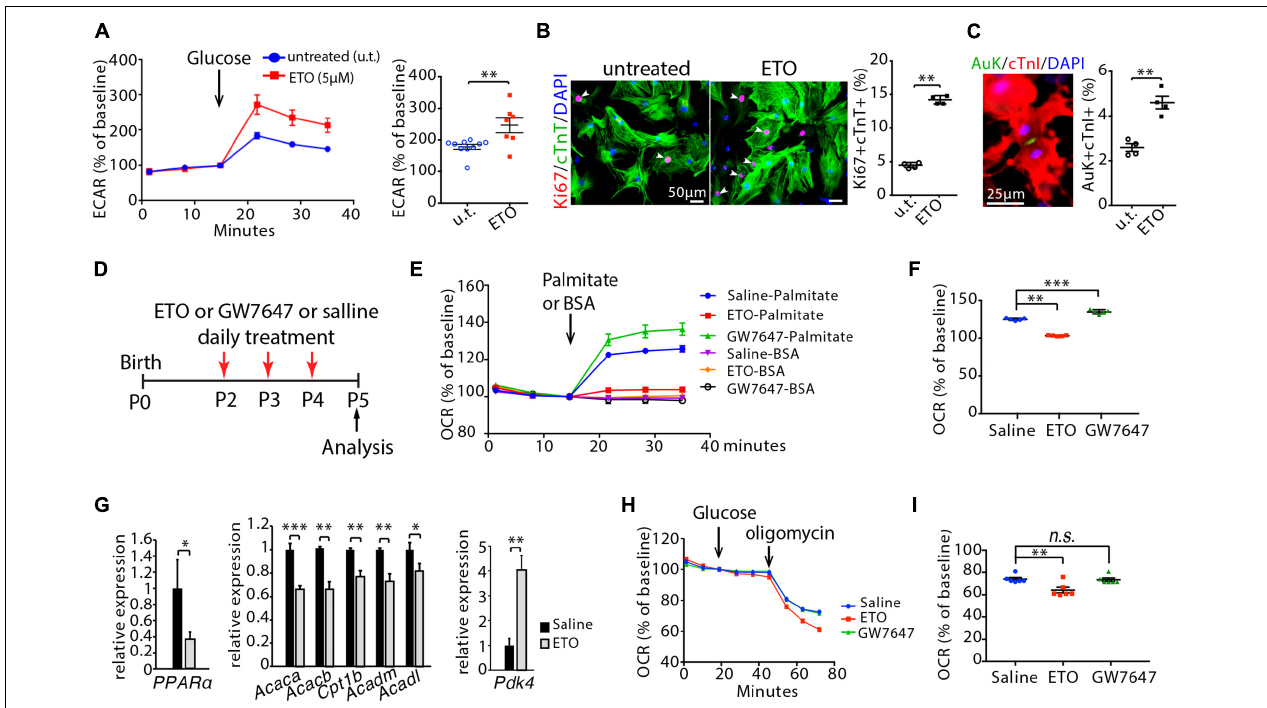
FIGURE 2 | Effects of etomoxir (ETO) and GW7647 treatment on cardiomyocyte metabolism. (A) Isolated neonatal mouse cardiomyocytes (P1) were cultured with medium containing ETO (5 µ M) for 48 h. ECAR was measured in cardiomyocytes using the Seahorse XF Analyzer. (B) Cardiomyocyte proliferation were visualized by co-immunostaining for Ki67 (red) and cTnT (green) on cultured cardiomyocytes, and quantification of Ki67+cTnT+ as percentage of total cTnT+ cells analyzed. Arrows point to Ki67+cTnT+ cells. (C) Cardiomyocytes in cytokinesis were visualized by co-immunostaining for Aurora B kinase (Auk, green) and cTnI (red) on cultured cardiomyocytes, and quantification of Auk+cTnI+ as percentage of total cTnI+ cells analyzed. (D) Schematic of experimental design for experiments performed in panels (E–I) . Infant mice were treated either with ETO or GW7647 or saline at P2, P3, and P4. Cardiomyocytes were isolated at P5 and processed for Seahorse analysis or gene expression analysis. (E,F) OCR was measured (E) and quantified in response to palmitate or BSA challenge (F) . (G) Expression of indicated genes by qRT-PCR analysis of the mRNA of isolated heart ventricles at P5 ( n = 4–6 per group). (H,I) OCR was measured in isolated cardiomyocytes at P5 (H) and quantified in response to glucose challenge (I) . P value was calculated using Student’s t -test (A–C, G) and one-way ANOVA (F, I)